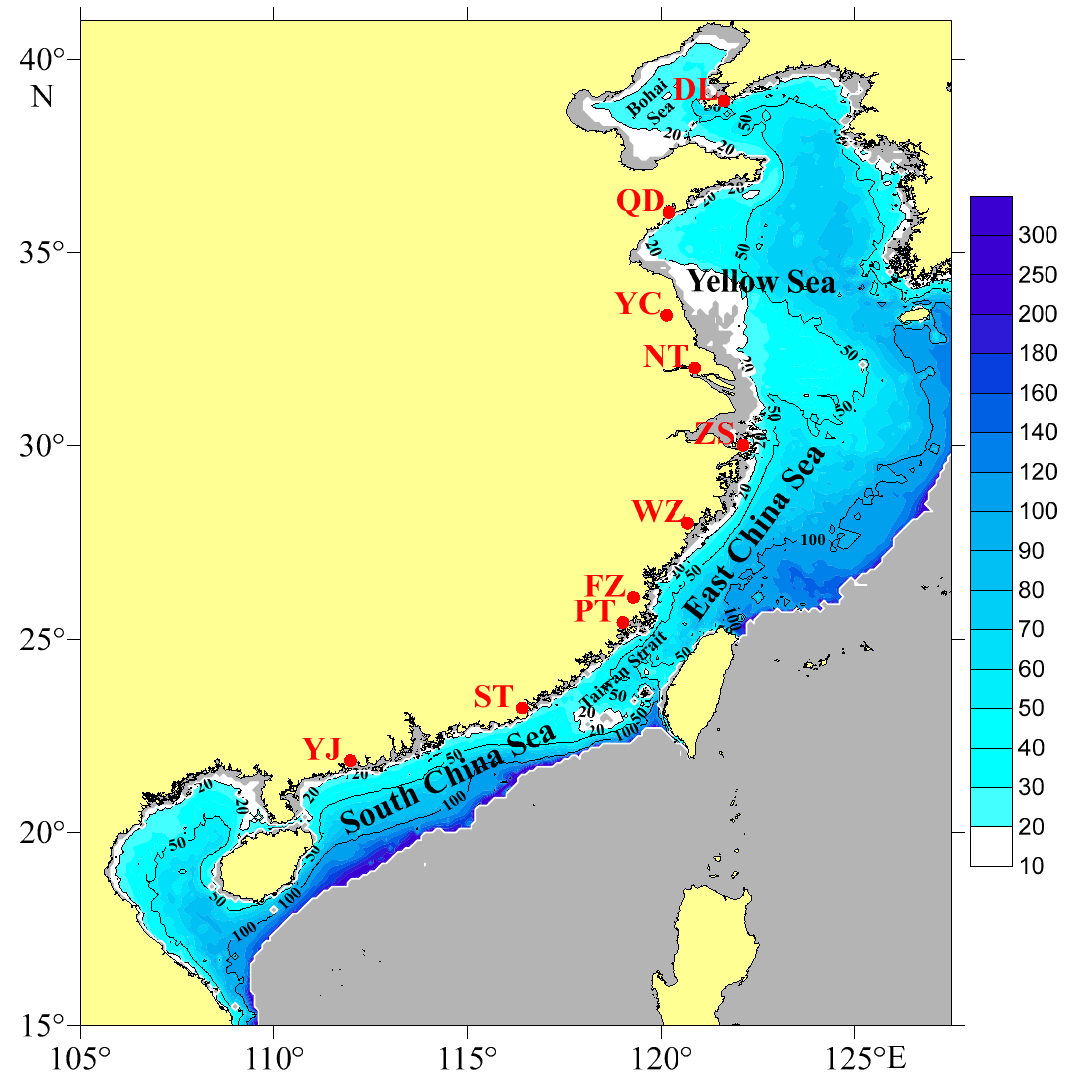
Figure 2. Bathymetry (m) of the waters adjacent to China. The regions (water depth < 10 m and >300 m) are covered by gray. The red dots are cities with massive OWF deployment plans. From south to north, the cities are Yangjiang (YJ), Shantou (ST), Putian (PT), Fuzhou (FZ), Wenzhou (WZ), Zhoushan (ZS), Nantong (NT), Yancheng (YC), Qingdao (QD), and Dalian (DL).